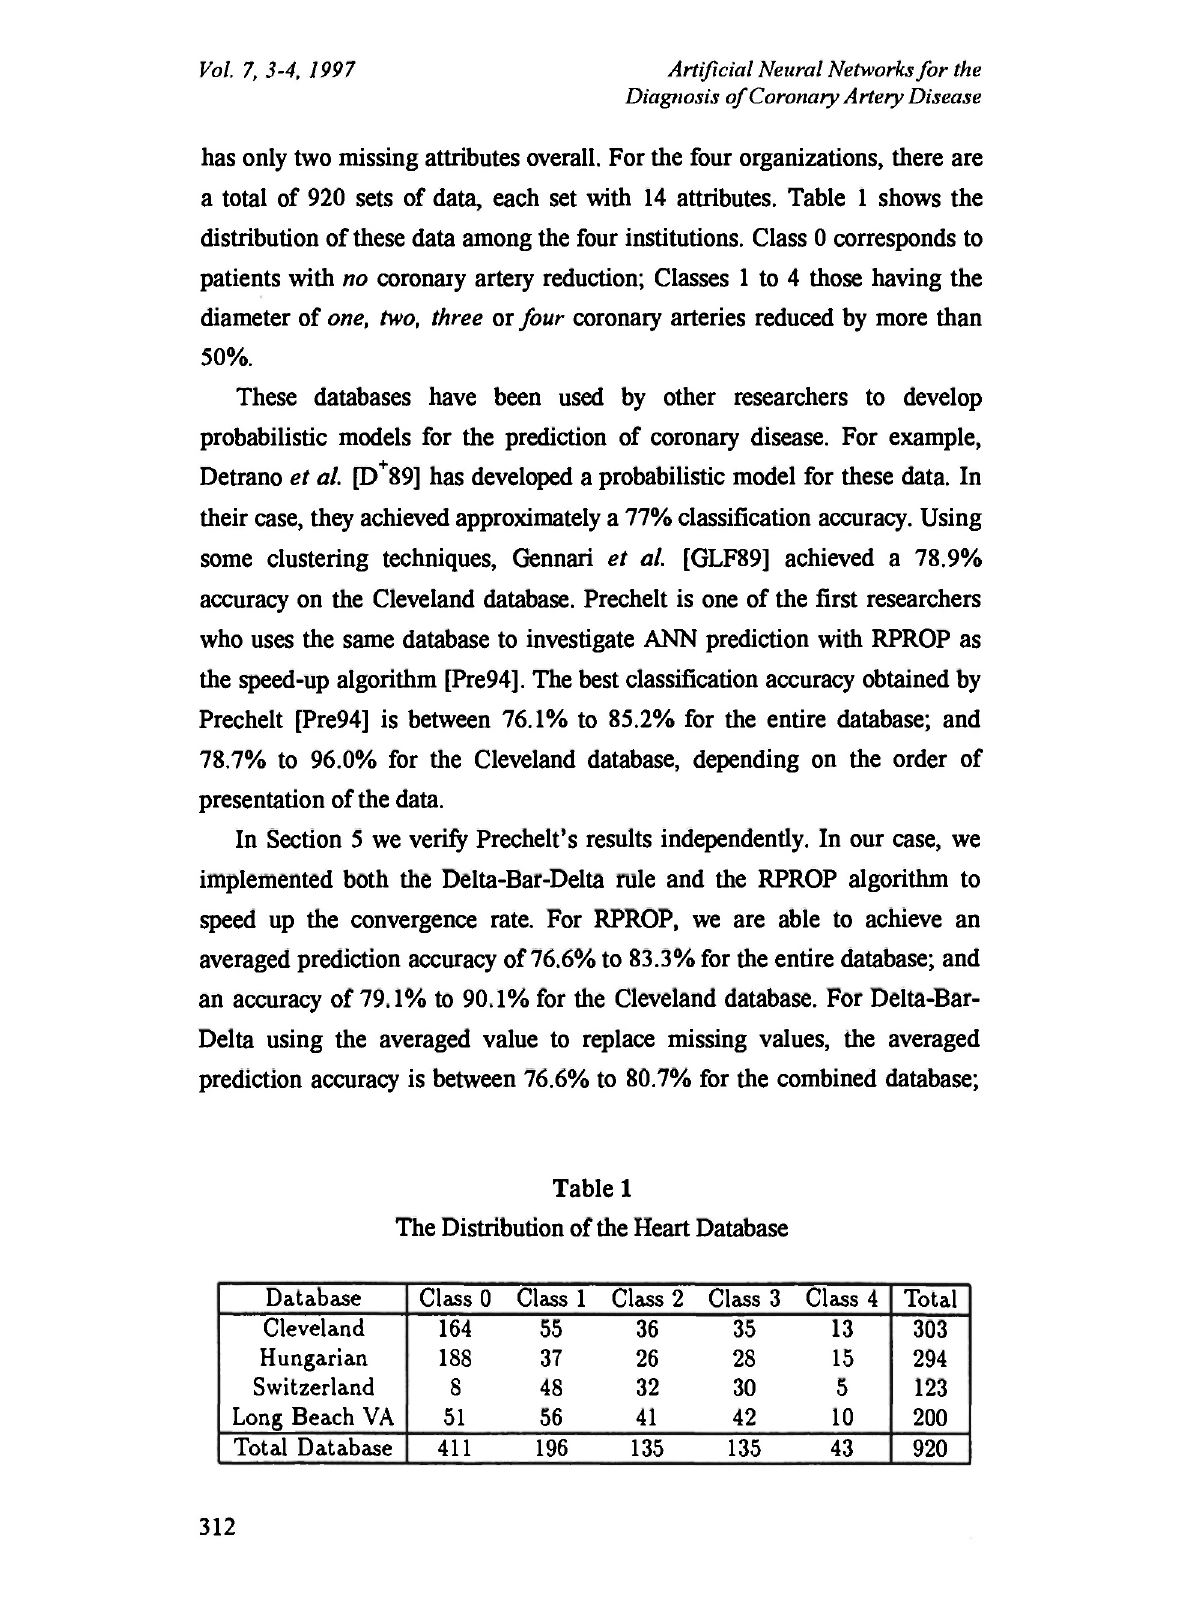
The Distribution of the Heart